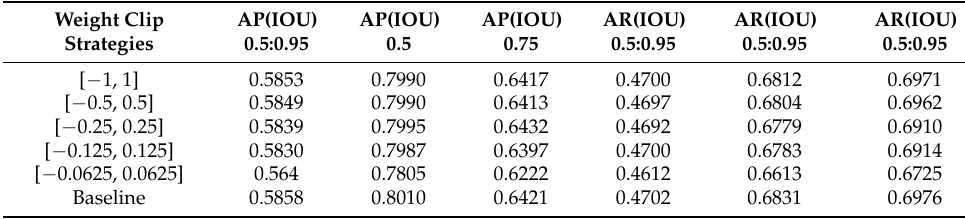
Table 2. Results of five weight clip strategies in float type during training.